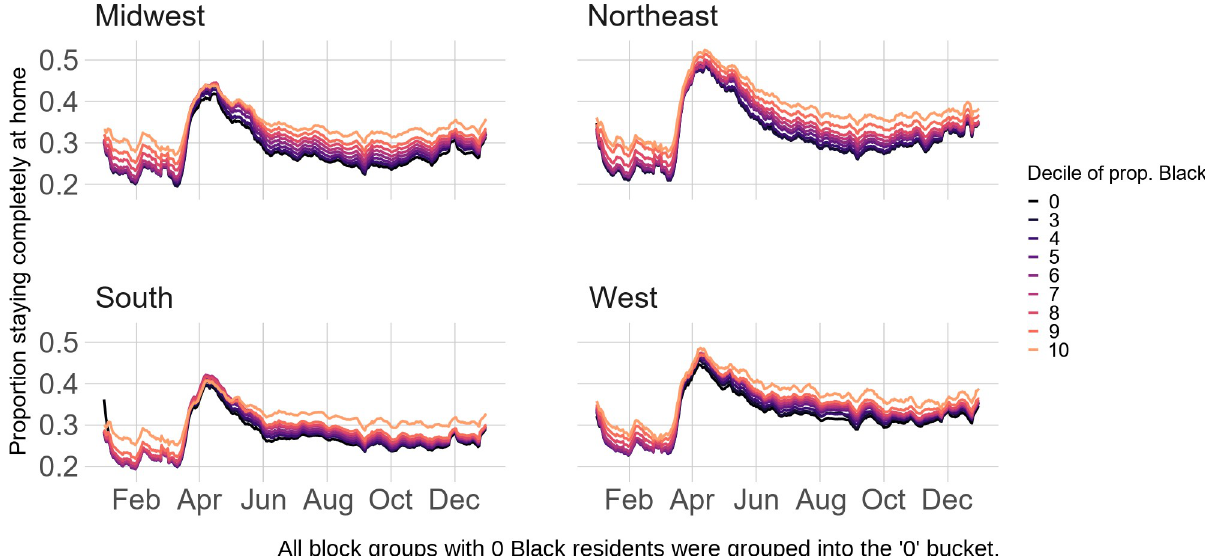
Fig 2. Stay-at-home patterns by Census region and proportion